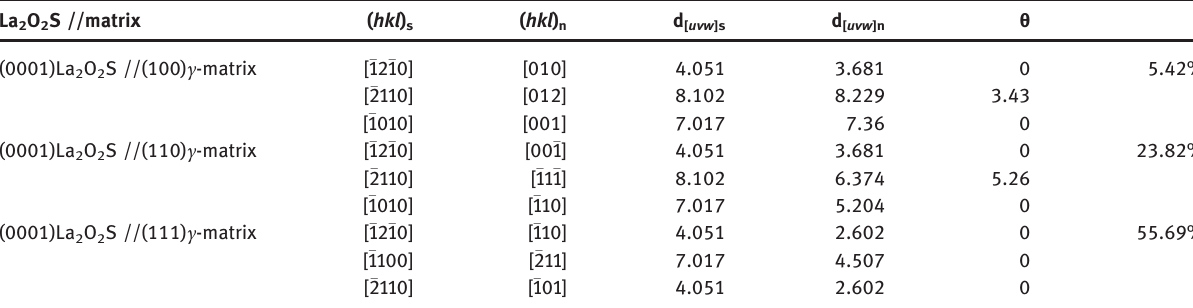
Table 3: Calculated values of lattice misfit between La 2 O 2 S and γ -matrix. La  O  S //matrix